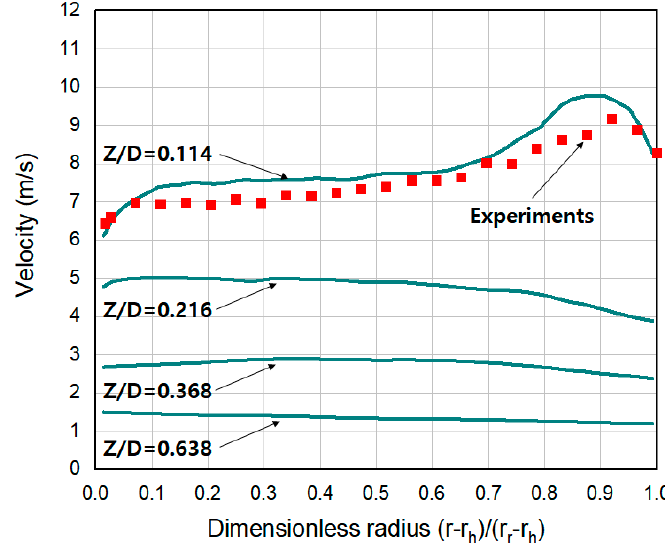
Figure 8. Velocity distributions at each section at y = 0 section in the upstream and comparison with experiments.